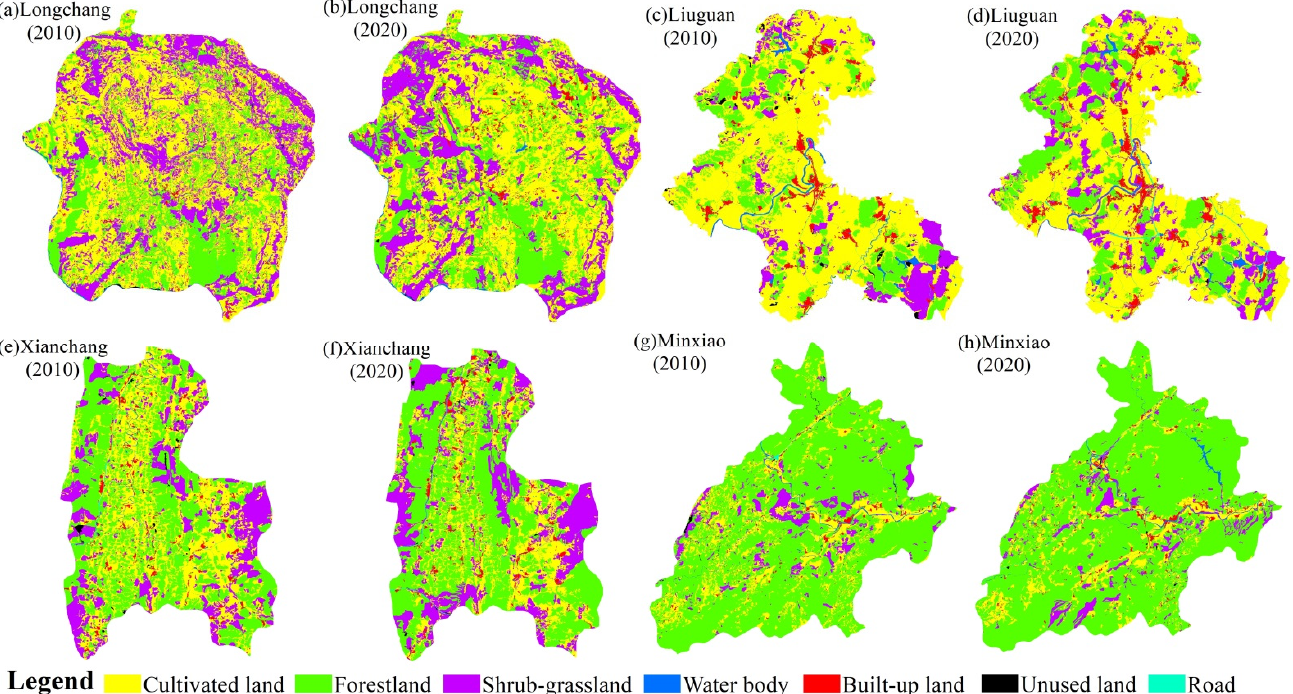
Figure 1. The locations of the four selected towns in karst mountainous areas. ( a ) Longchang, ( b ) Liuguan, ( c ) Xianchang, ( d ) Minxiao.